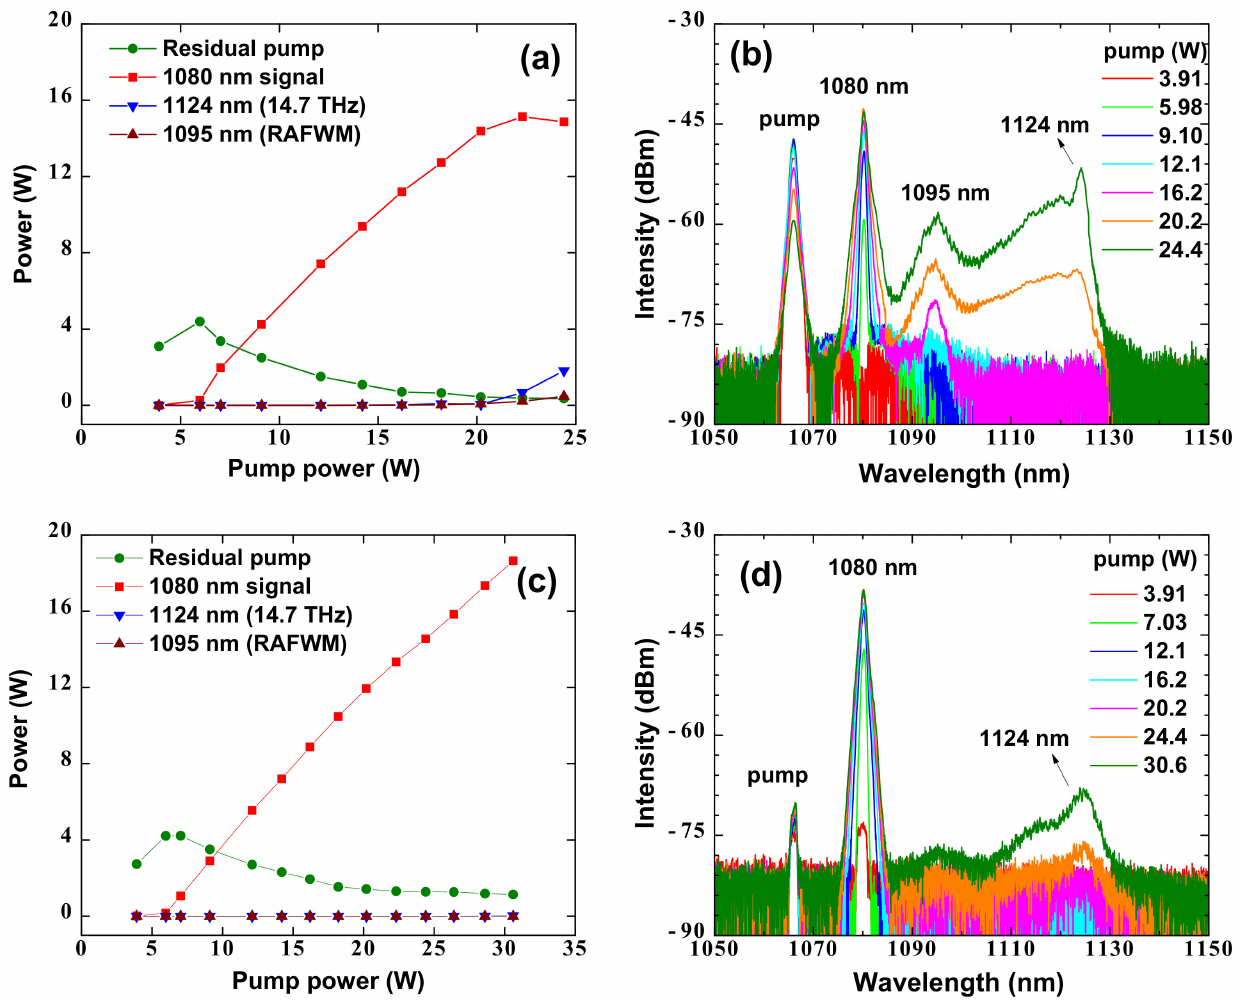
Figure 4. ( a )The power evolution of the forward-pumped low-quantum defect Raman fiber laser, ( b ) the spectra evolution of the forward-pumped low-quantum defect Raman fiber laser, ( c ) the power evolution of the backward-pumped low-quantum defect Raman fiber laser, ( d ) the spectra evolution of the backward-pumped low-quantum defect Raman fiber laser. RAFWM, Raman-assisted four-wave